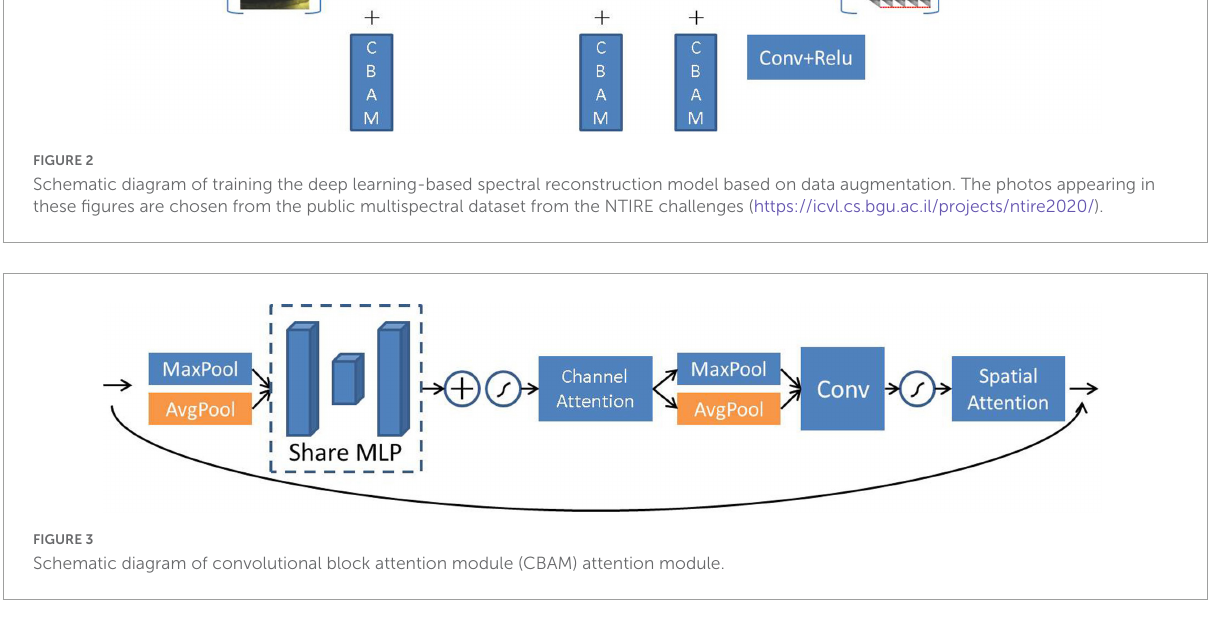
TABLE 1 Comparison of the mean relative absolute error (MRAE) (%) of different methods under different tested exposure levels. Exposure × 1 Exposure × 0.25